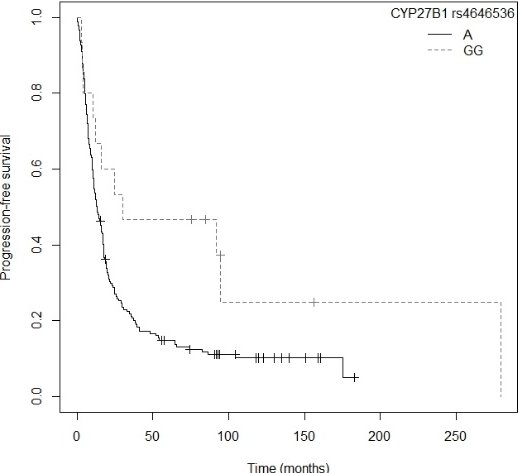
Figure 3. Kaplan–Meier plot of progression-free survival curves with the A allele of the CYP27B1 rs4646536 gene polymorphism in 194 patients with NSCLC. Table 4. Influence of gene polymorphisms and clinical characteristics on progression-free survival of 194 NSCLC patients.